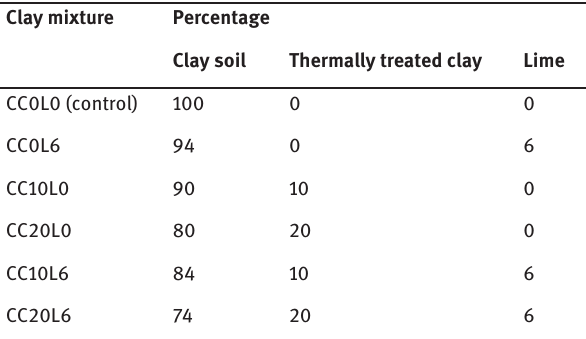
Table 3: Clay mixtures used in the study. Clay mixture